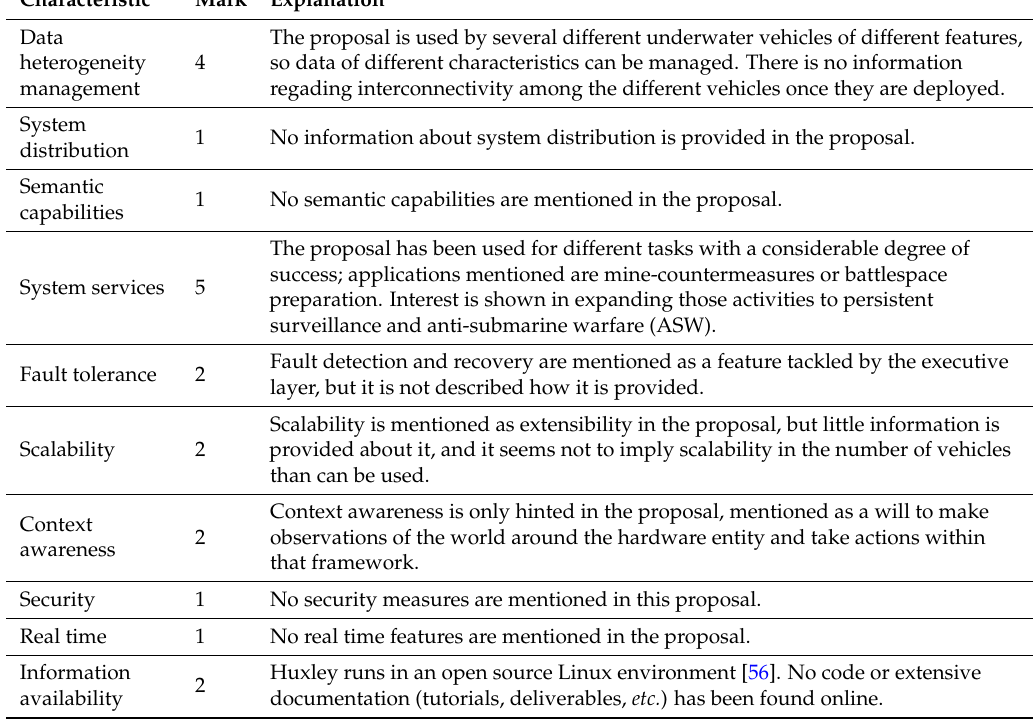
Table 20. Huxley assessment.